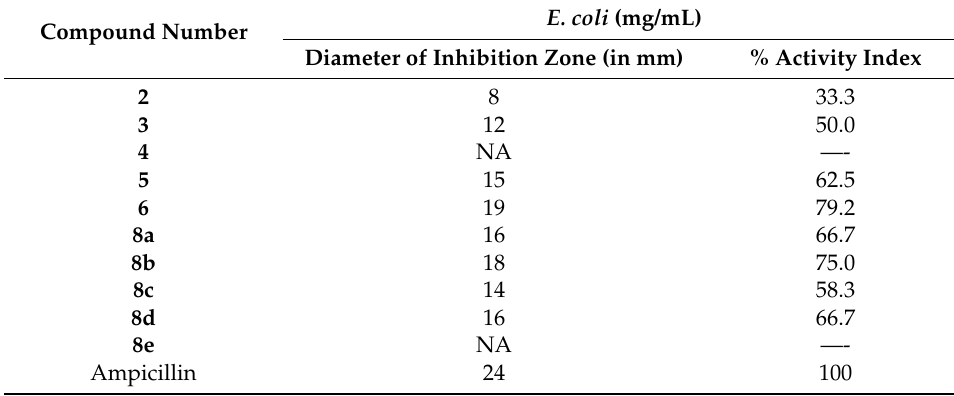
Table 2. Antibacterial activities expressed as inhibition diameter zones in millimeters (mm) of the tested compounds against Escherichia coli